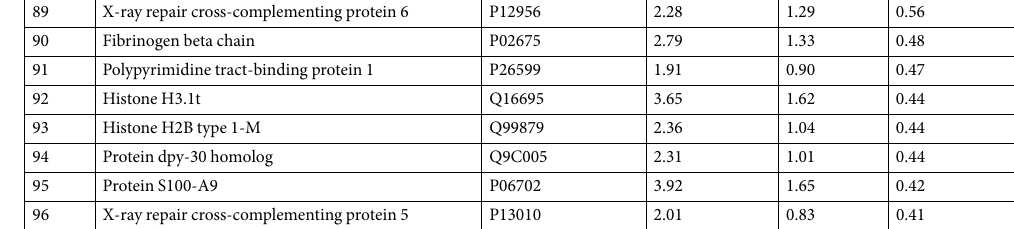
Table 2. List of significantly altered serum and tissue proteins in SVZ + / − GBM tumor samples with respect to normal brain tissue identified using iTRAQ method (Partial list of significantly altered proteins is given in the